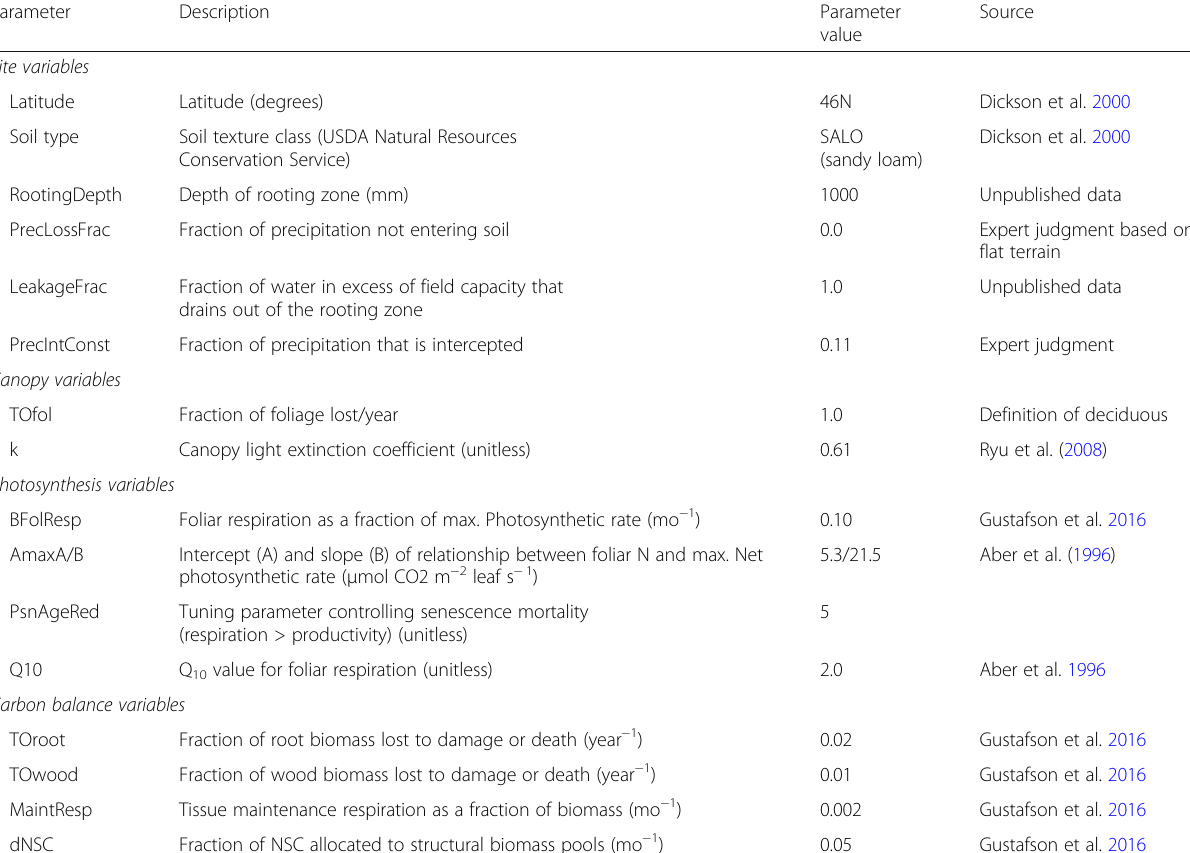
Table 2 Generic (apply to all taxa) parameter values used in the